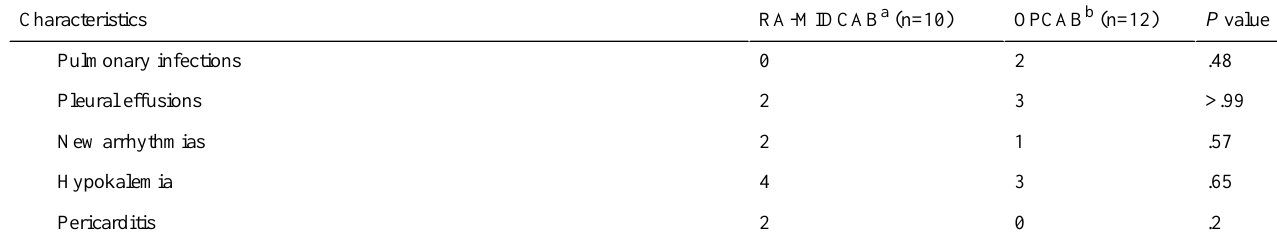
Table 2. Step count analysis recorded by Fitbit Charge HR in RA-MIDCAB and OPCAB patients. Overall analysis, median (min, max), n